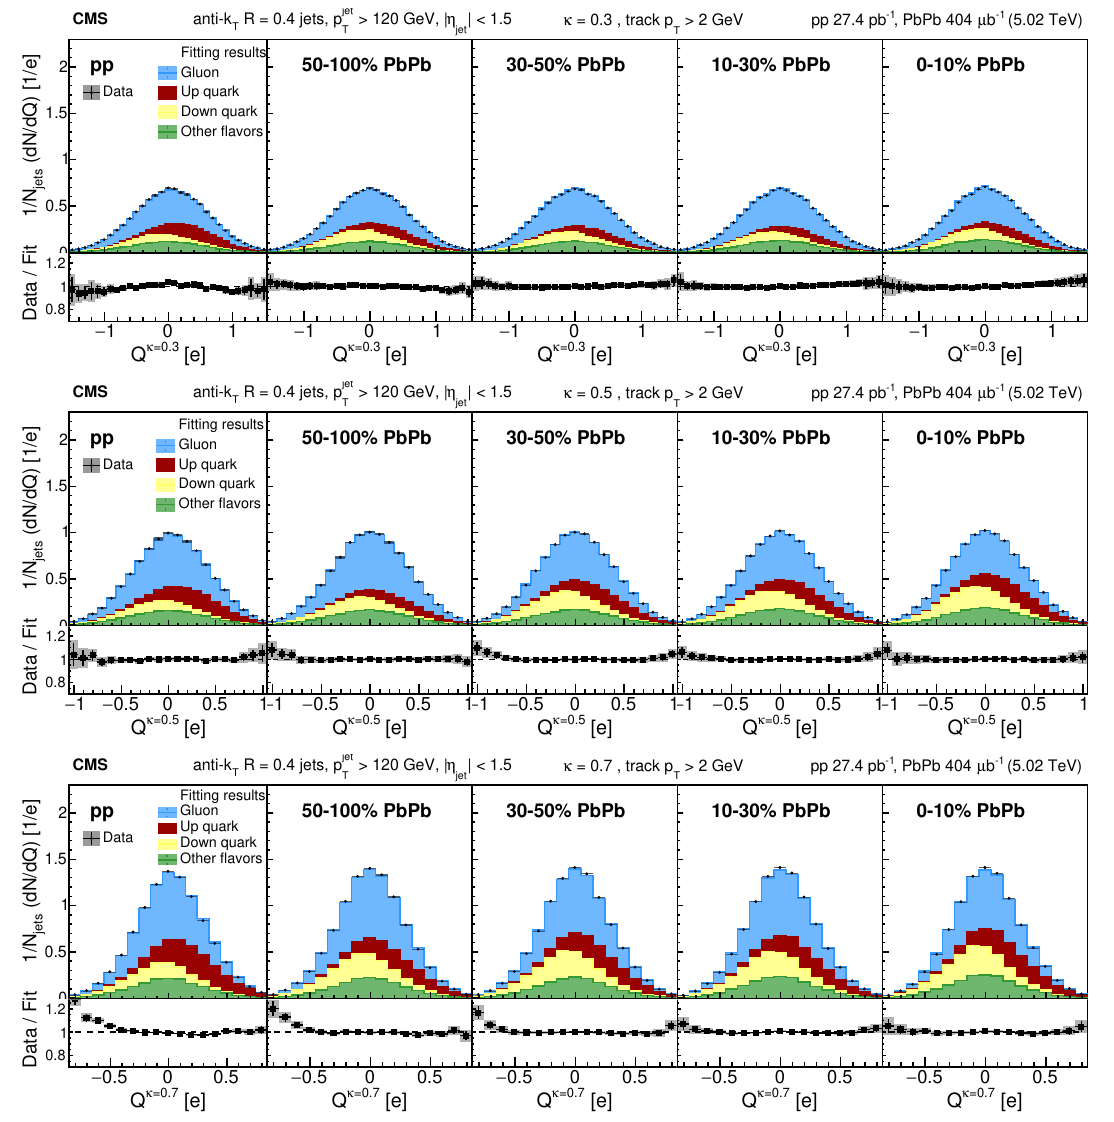
Figure 7 . (Upper row of each (cid:12)gure) Unfolded jet charge measurements shown for inclusive jets in data along with the extracted fractions of up, and down quark jets, gluon jets, and the \other (cid:13)avor" jets. The systematic and statistical uncertainties in the distributions are shown by the shaded regions and vertical bars, respectively. The jet charge measurements shown here are for a minimum track p of 2 GeV and a (cid:20) value of 0.3, 0.5, and 0.7 (top, middle, and bottom, respectively). T (Lower row of each (cid:12)gure) Ratio of the jet charge measurements to the results of template (cid:12)ts.